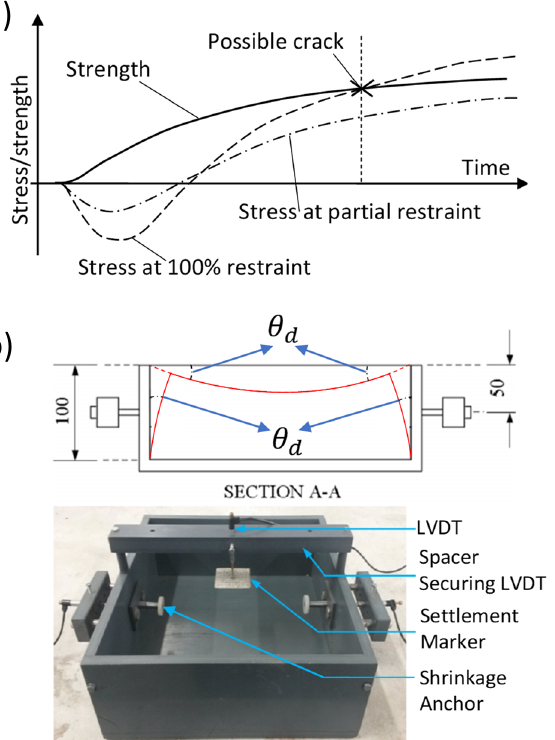
Figure 14. (a) Cracking risk/potential in a concrete element at partial and full restraint [40], (b) Settlement and shrinkage mould (300x300x100 mm) for estimating shear strains ( 𝜃 (cid:3031) ), assuming full restraint (reproduced with permission from